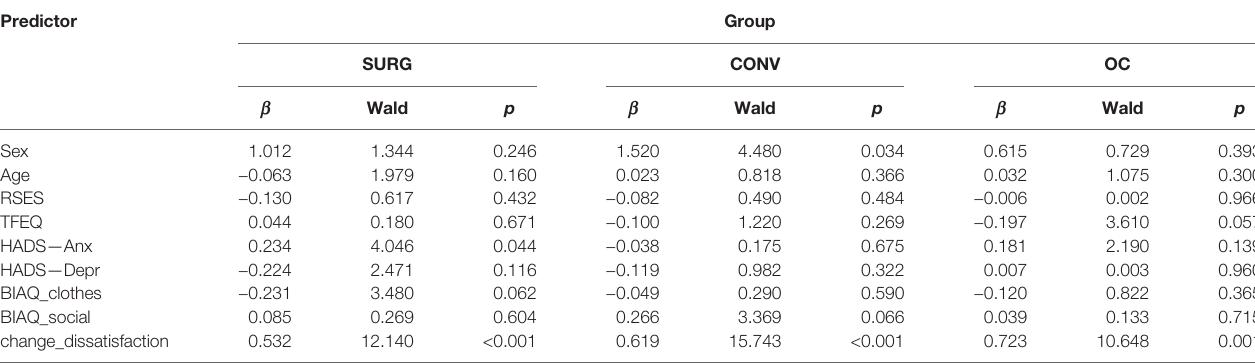
TABLE 4 | Third step regression analyses for weight loss maintenance.